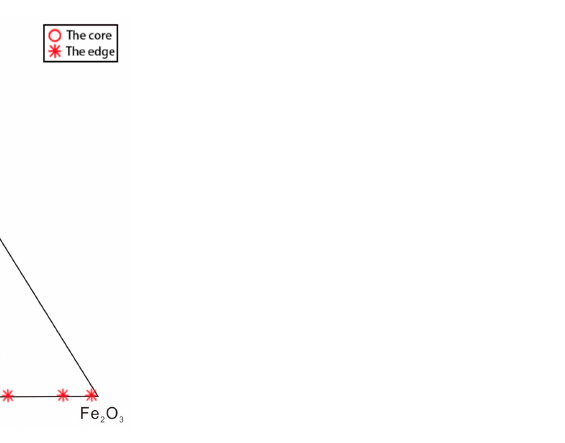
Figure 6. Classification graph of chromite [36] in “Laoshan Jade”: 1—ferrichromite; 2—ferrochromite; 3—picroalumochromite; 4—ferrochromopicotite; 5—ferroalumopicotite; 6—ferropicotite; 7—picotite; 8—alumopicotite; 9—chromopicotite; 10—alumochromite; 11—chromite; 12—errochromo- picotite.